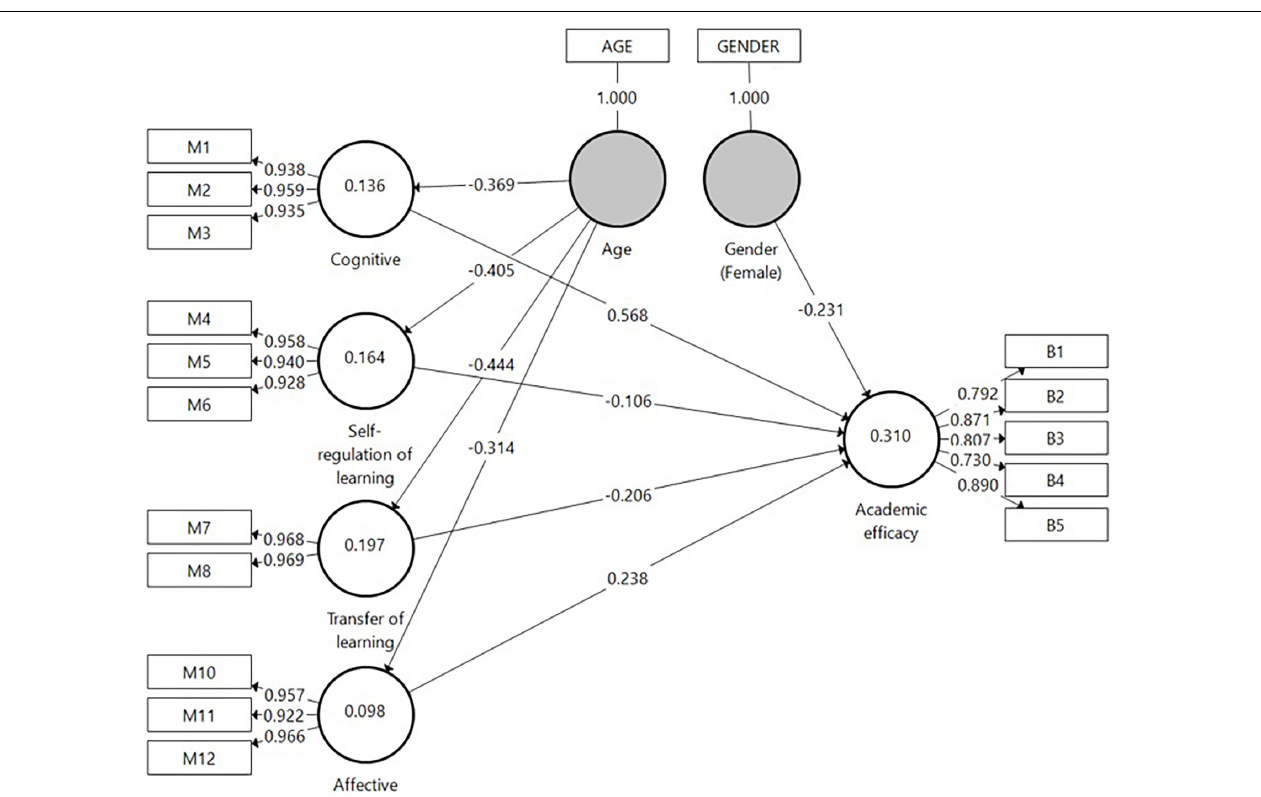
FIGURE 5 | Model 2 analysis results of the examination of H2 by